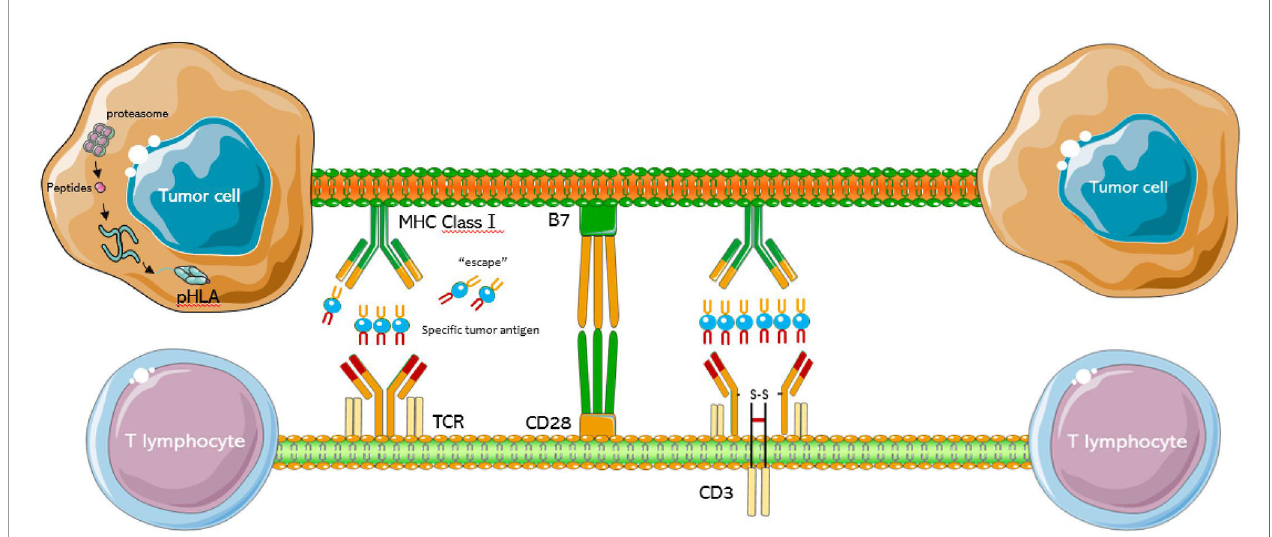
FIGURE 1 | Schematic diagram of the TCR-T cell structure. The TCR complex is a heterodimer consisting of two different peptide chains. The MHC class 1 present intracellular antigenic peptides of cancer cells for recognition by the T cell receptor, and surround by CD28 and